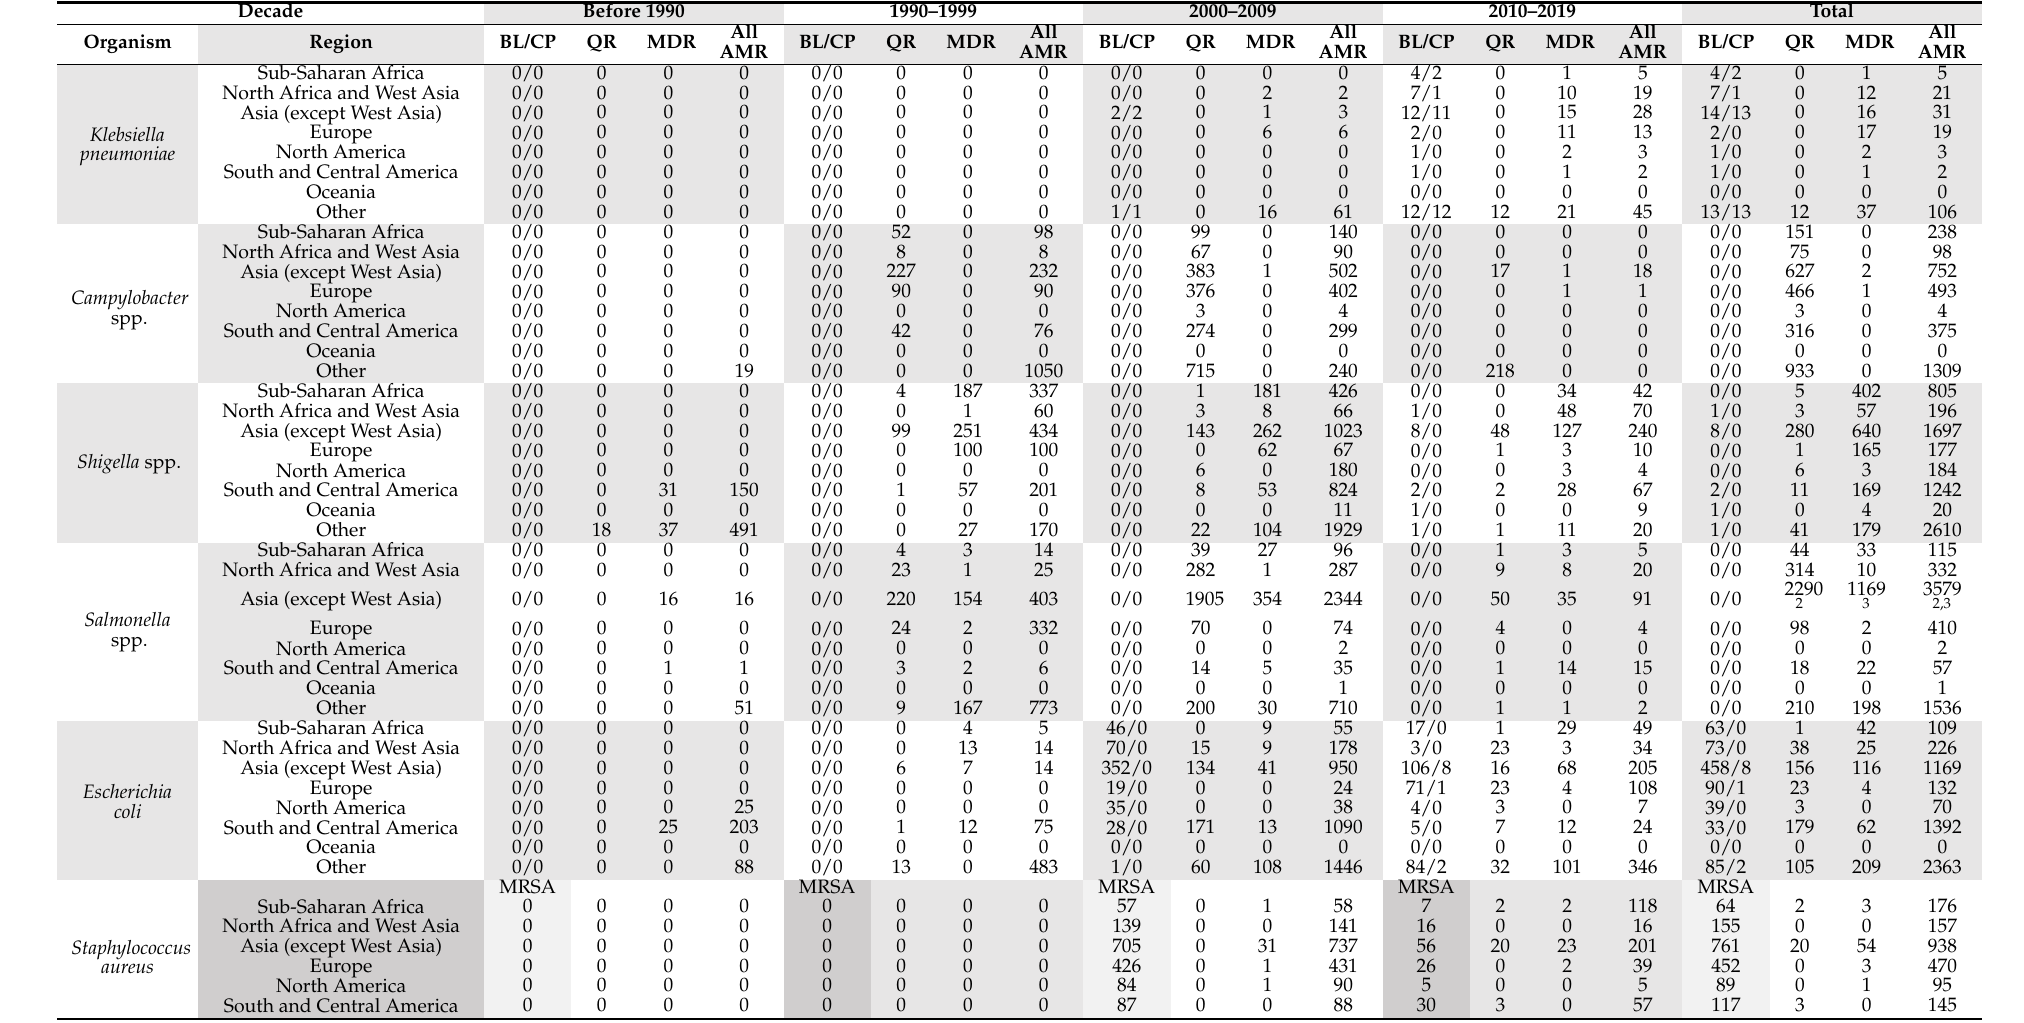
Table 2. Distribution of the number of AMR isolates by decade for nominated species 1 separated by